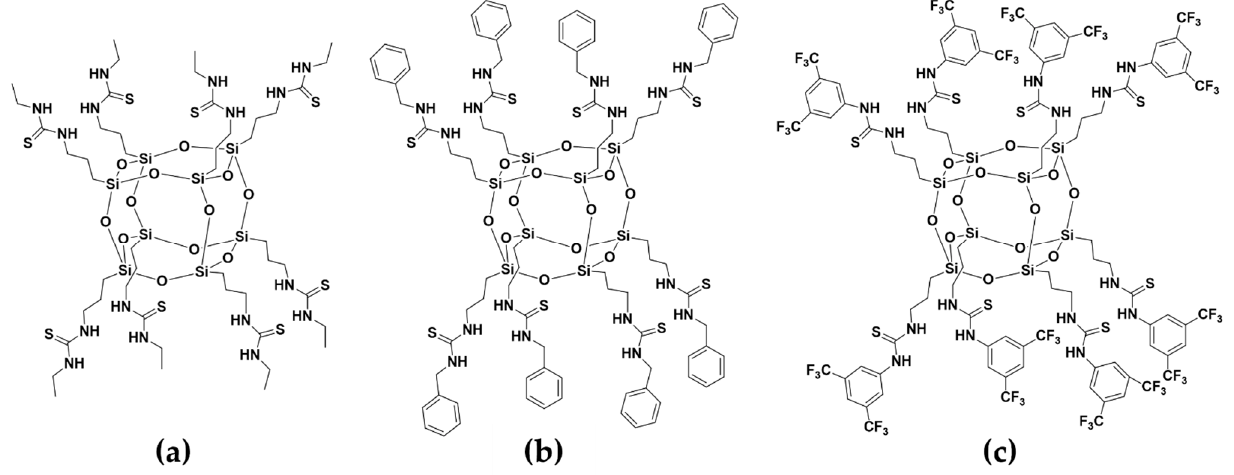
Figure 4. Synthesized material: ( a ) PSS-TU1, ( b ) PSS-TU2, ( c ) PSS-TU3.